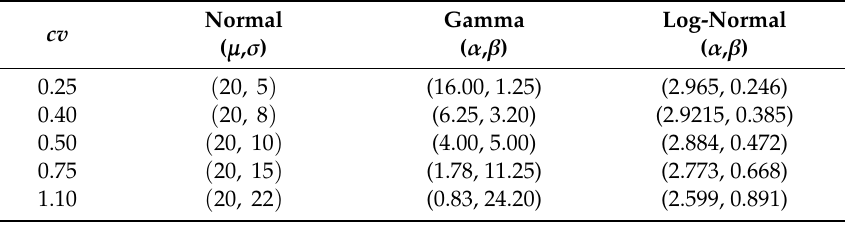
Table 5. The parameters of the three distributions.